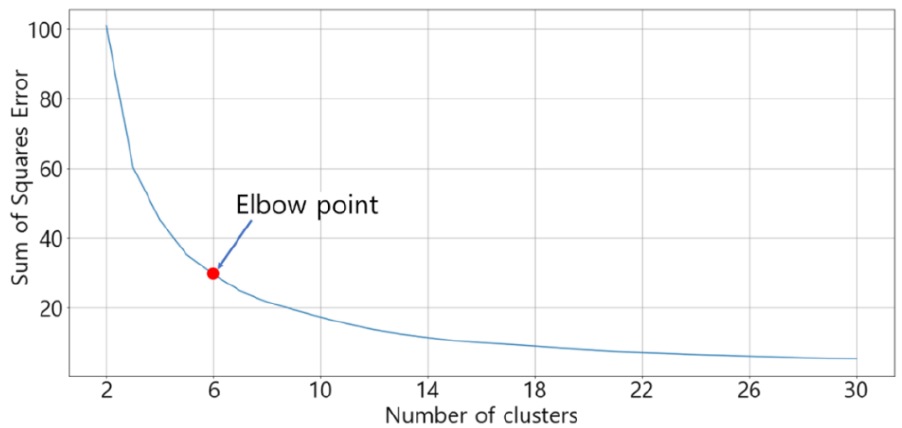
Figure 4. Sum of squares error (SSE) of residential customers clustered with K-means. Figure 5a shows the cluster that represents a typical energy consumption pattern for residential customers. Figure 5b shows the energy saving cluster, which saves energy in the morning. Figure 5c shows the M-pattern cluster with similar energy consumption in the morning and the evening. Most residential customers in the M-pattern cluster are office workers. It is recognized in the M-pattern cluster that energy consumption increases before leaving for work. Energy consumption of residential customers within M-pattern cluster is relatively low since residential customers within the M-pattern cluster do not normally stay at home during daytime. Figure 5d shows the morning concentrated cluster with energy consumption concentrated in the morning. In general, residential customers within the morning concentrated cluster tend to use high energy consumption appliances such as washer machines and vacuum cleaners in the morning, resulting in high energy consumption in the morning. Figure 5e shows the evening concentrated cluster with energy consumption concentrated in the evening. In contrast, residential customers within the evening concentrated cluster tend to use high energy consumption appliances in the evening, resulting in high energy consumption in the evening. Figure 5f shows the owl cluster with relatively large energy consumption at daybreak compared to the other clusters. The owl cluster shows patterns of energy consumption behavior that consistently use energy until daybreak, like owls, and have very low energy consumption during the daytime. Table 4 shows the results of the analysis of the characteristics of each cluster: monthly total energy consumption, area, and number of household members. In addition, the energy-consuming cluster and energy-saving cluster have the same area of 100 m 2 ~132 m 2 . However, the number of household members shows different characteristics; the energy consumption cluster has two members, and the energy-saving cluster has four members. The M-pattern cluster, the morning concentrated cluster, and the evening concentrated cluster show similar characteristics in area and number of household members. However, differences in energy consumption behavior patterns result in different monthly total energy consumption. The owl cluster tends to have an area of less than 66 m 2 and single- person households. Their monthly total energy consumption is the smallest at 230.24 kWh because the area and the number of household members are smaller than those of the other